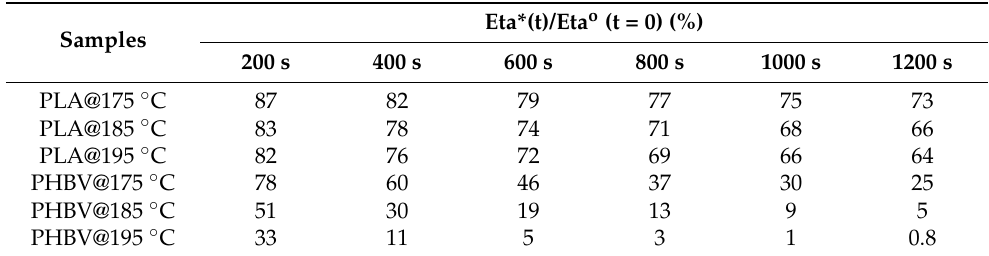
Figure 4. Results from the rheological dynamic time sweep measurements of pure PLA and PHBV at various temperatures. ( a ) Complex viscosity Eta*(t) versus time t; ( b ) complex viscosity divided by zero complex viscosity Eta*(t)/Eta°(t = 0) versus time t. Table 3. Results of the rheological dynamic time sweep measurements of pure PLA and PHBV at various temperatures.